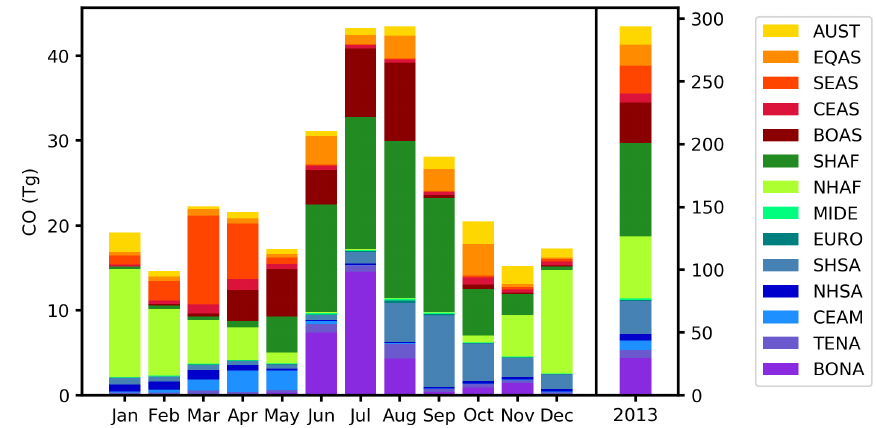
Figure 4. GFAS 2013 monthly and yearly emitted amounts of CO (in Tg) for the 14 geographical areas defined in Fig. 2.